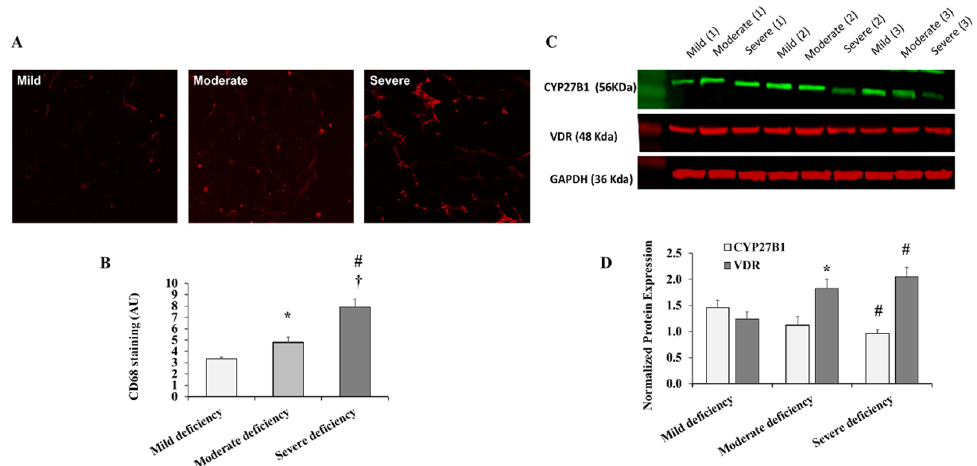
Figure 3. VAT macrophages and protein levels of CYP27B1 and VDR across VD deficiency categories. ( A ) Representative image of CD68 fluorescent staining in VAT from 3 subjects (1 per each VD deficiency group). ( B ) A quantification chart showing the means ± standard error (SE) of the fluorescent signal intensity expressed in arbitrary units (AUs). ( C ) Representative Western blots for analyzing VAT-extracted proteins from 9 subjects (3 per each VD deficiency group). ( D ) A quantification chart showing the means ± standard error (SE) of the target protein signal intensity normalized to the housekeeping gene, GAPDH. A significant p -value is represented by * for comparing the mild and moderate deficiency groups, # for comparing the mild and severe deficiency groups, and † for comparing moderate and severe deficiency groups.